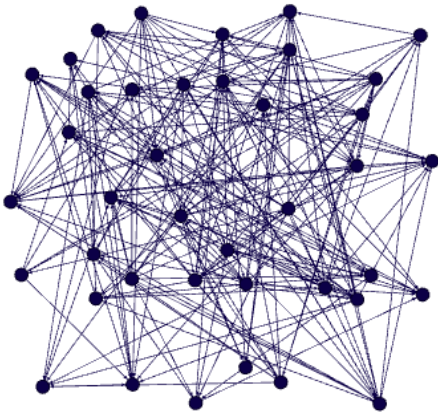
Figure 2. A sample network topology.